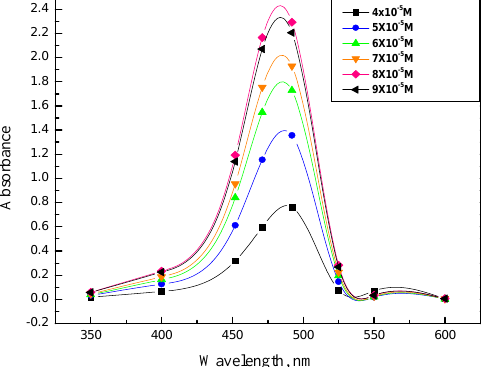
Figure 1. Absorption spectrum of AO at various